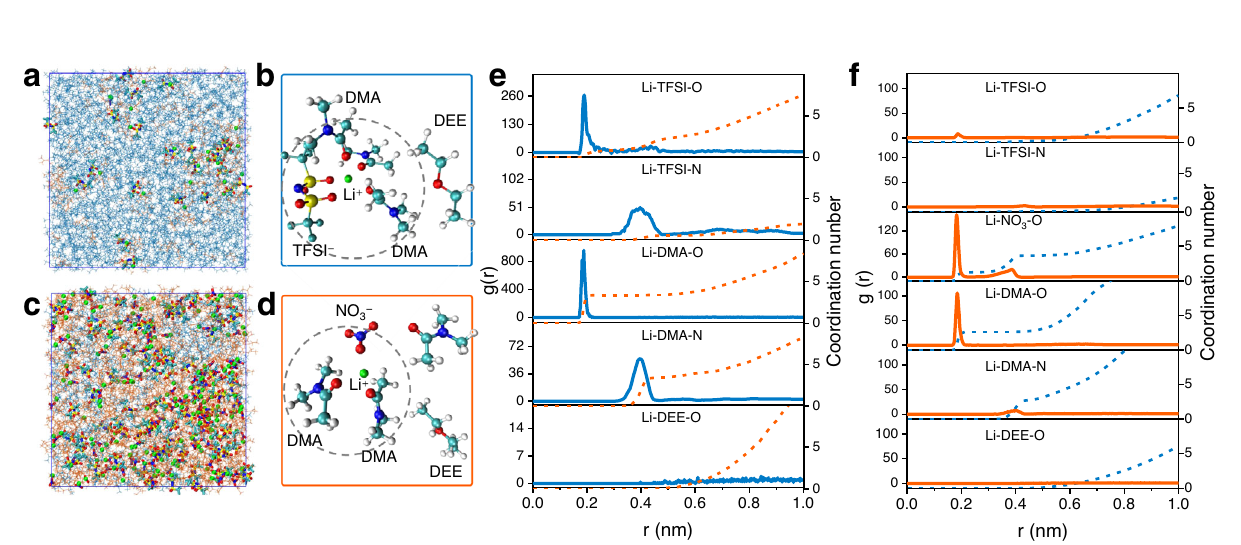
systems (No. 2, No. 3, No. 7) as a function of the simulation time. The diffusion coef fi cient of Li + was deduced by fi tting. d Li + conductivity of the top and bottom phasesinNo.2,No.3,andNo.7biphasicsystems. e ProportionsofDEE,DMA,LiNO 3 and LiTFSI in the top and bottom phases of the No. 2 biphasic system.